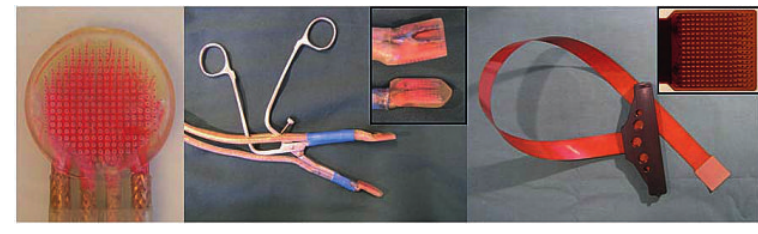
Isochronal map of an endo-epicardial recording of AF using the “crocodile” elec- trode in a goat. Both maps are recorded simultaneously at ex- actly opposing sites on the epicardial and the endocardial sur- face, respectively. Isochronal lines indi- cate 5 ms time differ- ences, earliest activa- tion is in red, latest in blue. Arrows repre- sent local direction of propagation. White stars mark sites of supra-normal local conduction velocities due to oblique activa- tion. Comparing the endocardial with the epicardial activation pattern reveals, that during AF electrical dissociation in time (delta activation time lower right corner = 35 ms) and direction of propagation (difference in direc- tion of propagation upper left corner = 180°) between the subepicardial layer and the endocardial bundle network is